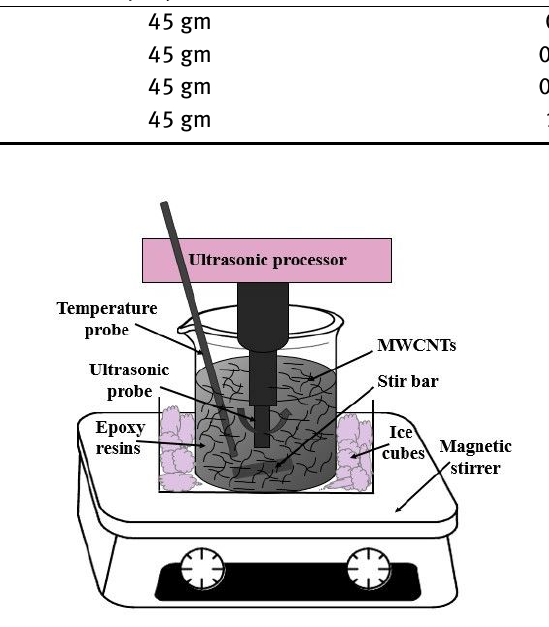
Figure 1: Schematic of UDM technique to prepare the MWCNT-epoxy